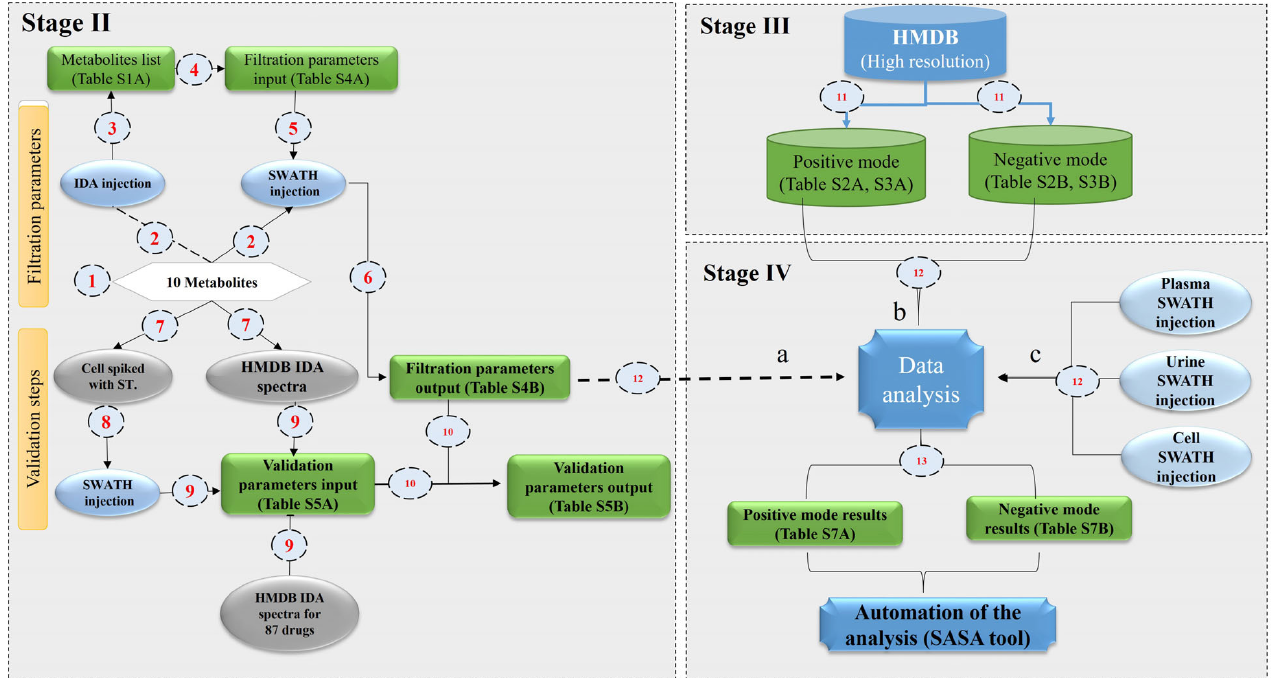
Figure 2. Validation, spectral library generation, and data analysis pipeline. Stage II clarifies the filtration and validation steps using the spiked-standard mixture in both IDA and SWATH analysis. Stage III explains HMDB version 4.0 spectral library generation. Stage IV demonstrates the strategy of the biological data analysis workflow. Green shaded boxes are described in the supplementary spreadsheet. Numbers 1–13 clarify the schematic workflow direction through the different stages. The letters a, b, and c explain the sequential data analysis.